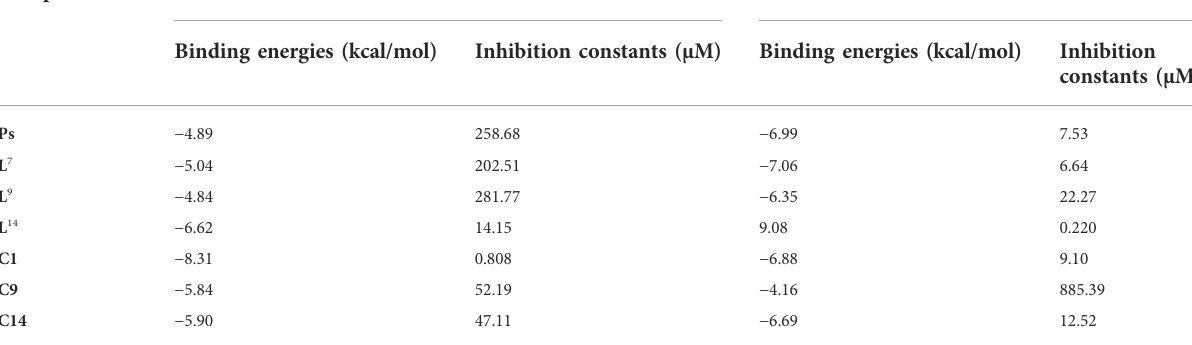
TABLE 1 Calculated binding energies (in kcal/mol) and inhibition constants (in μ M) for Ps, some ligands (L 7 , L 9 , and L 14 ) and copper(I) complexes (C1, C9, and C14). The binding energies and inhibition constants of the other ligands and complexes can be found in the Supplementary Material (Supplementary Table